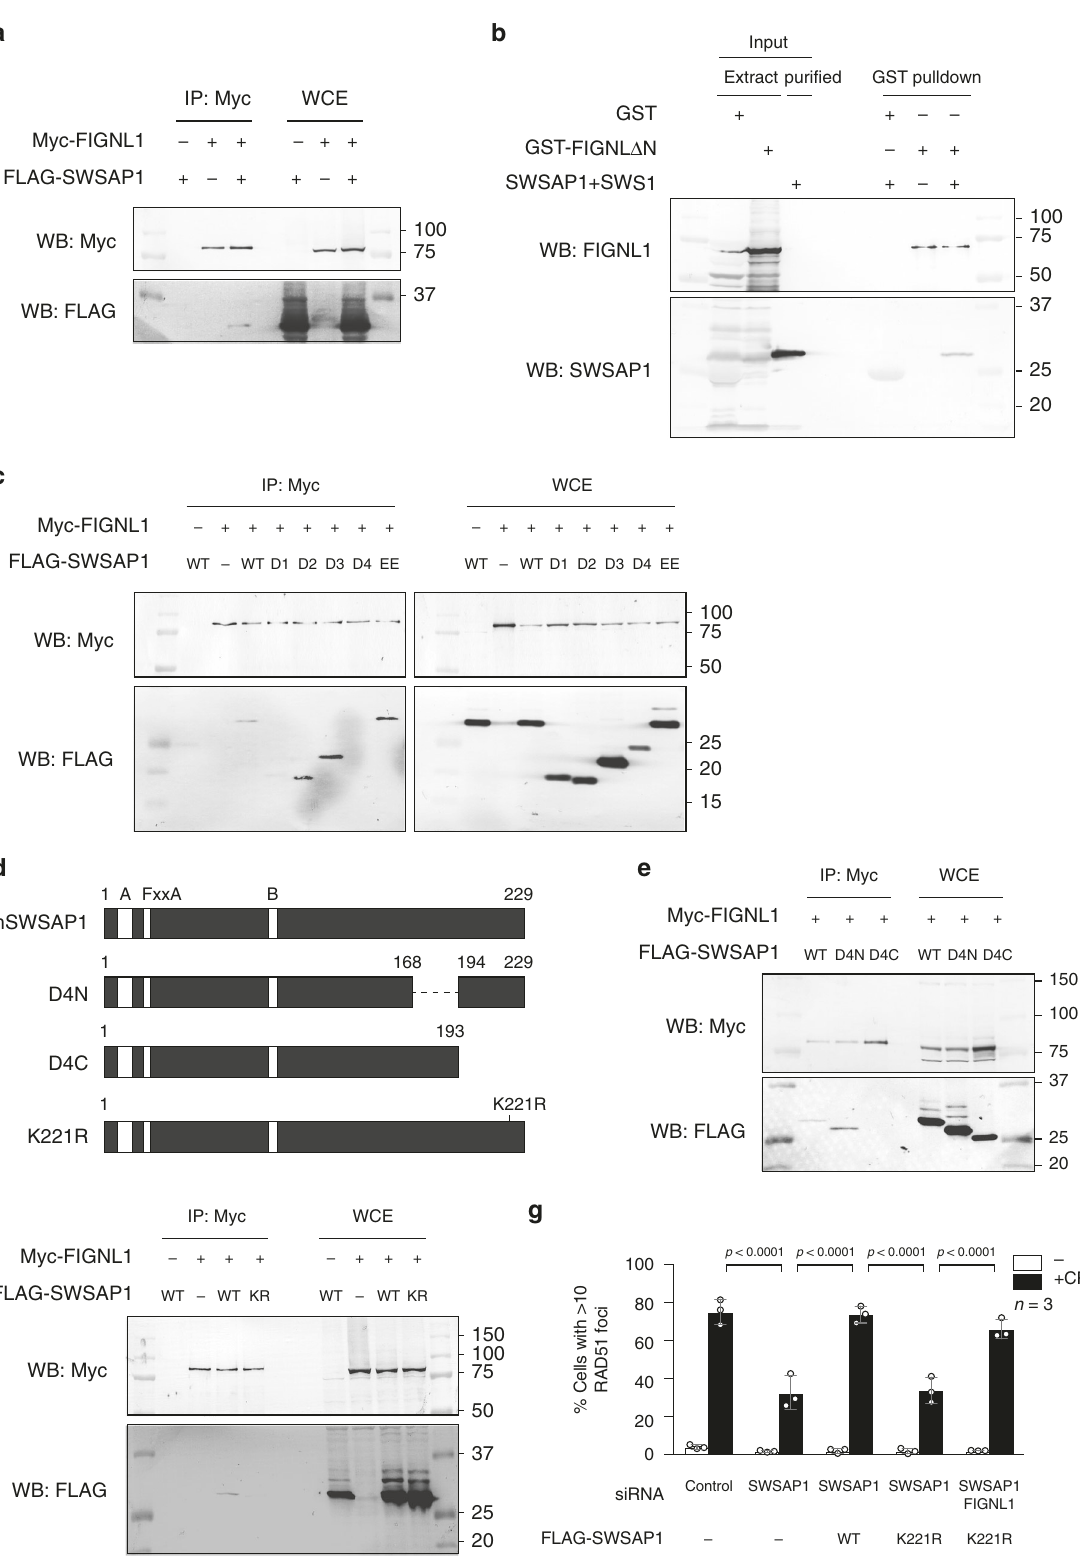
(Fig. 4b). Concomitantly, the amounts of RAD51 bound to ssDNA (ssDNA-bound) were reduced. These data indicate that FIGNL1 promotes the dissociation of RAD51 from ssDNA.